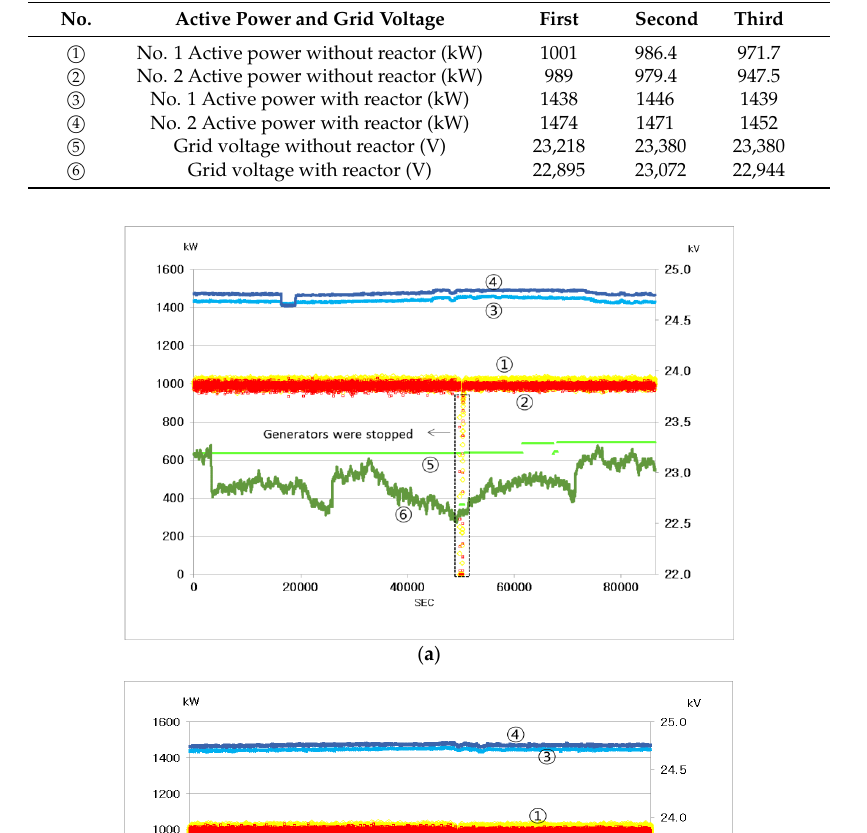
Table 5. Comparison of output active power and daily grid voltage before and after installing reactors.